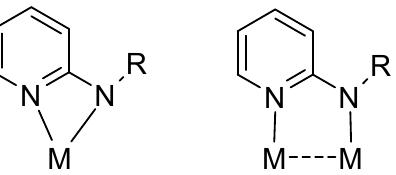
Figure 1. Chelating and bridging coordination modes of aminopyridinato ligands (R = alkyl, aryl or silyl; M = transition metal).